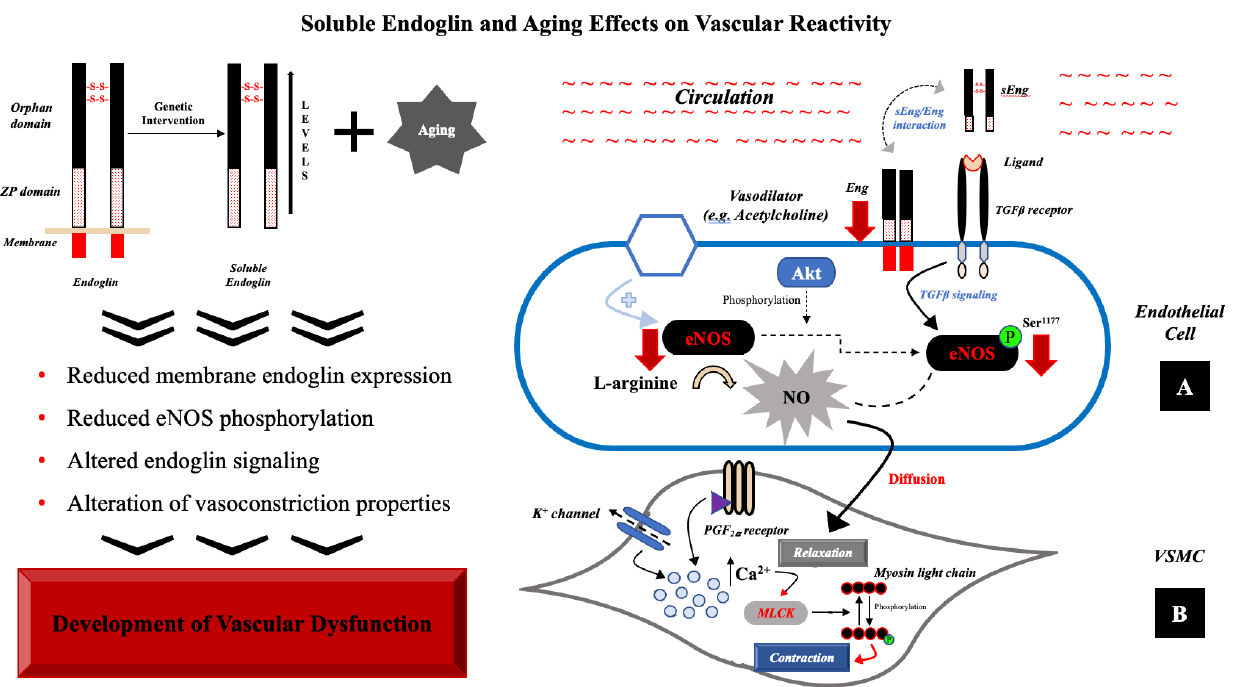
Figure 6. Role of sEng with aging in vascular dysfunction. ( A ) In endothelial cells, sEng and aging reduce Eng expression (red arrow) and signaling resulting in reduced expression of eNOS (red arrow) and its reduced phosphorylation rate (red arrow). ( B ) Vasoconstriction process, localized in VSMC, consists in phosphorylation of myosin light chain by an activated form of myosin light chain kinase (MLCK). Binding to PGF 2 α receptor or activation of K + channel evoke changes in intracellular milieu, increasing calcium ion concentration. The presence of high levels of sEng and aging probably contribute to the alteration of